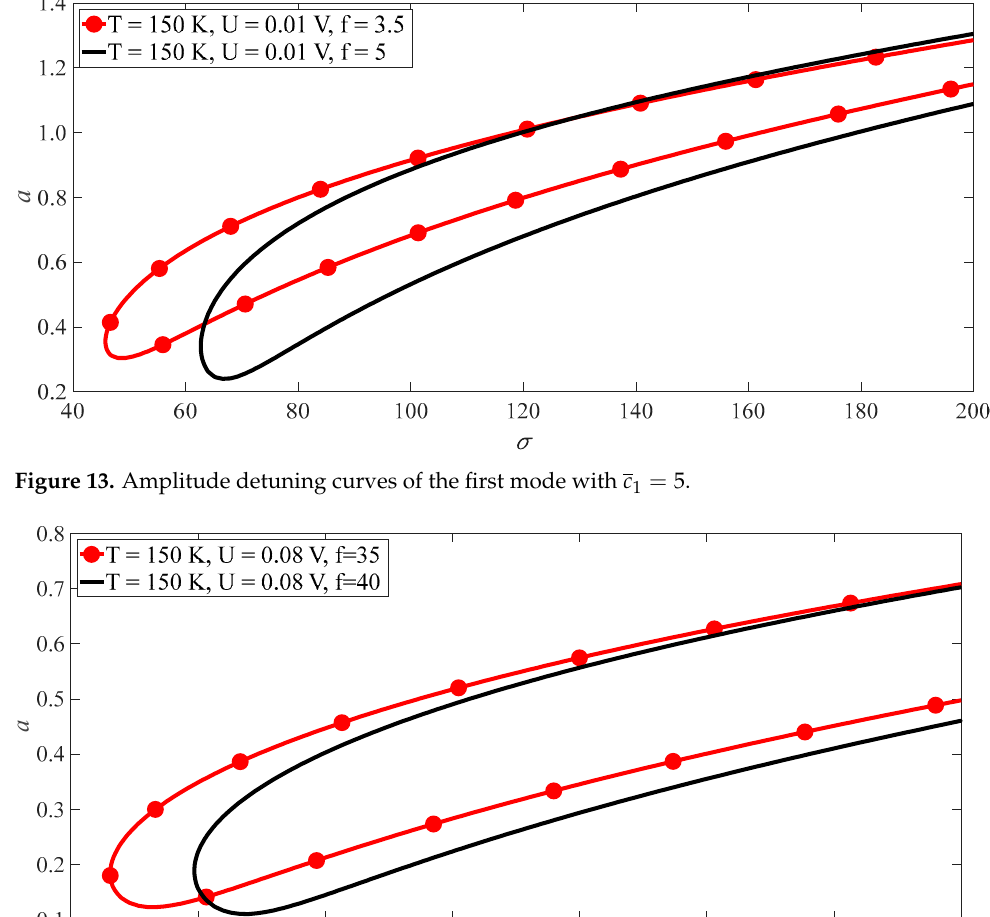
= 5 c . = 2 5 c . 2 = 5 c . 2